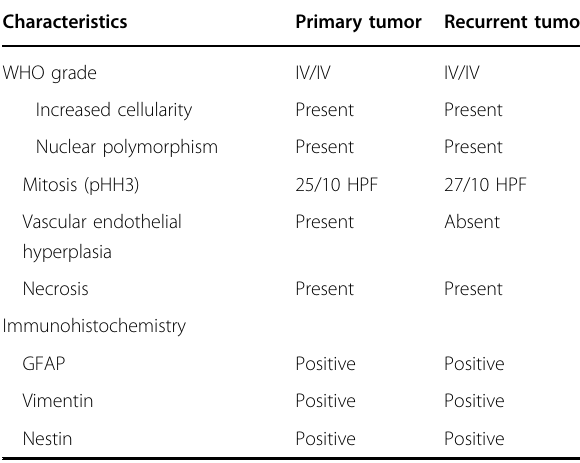
Table 1 Histological and immunohistochemical characteristics of primary and recurrent glioblastoma